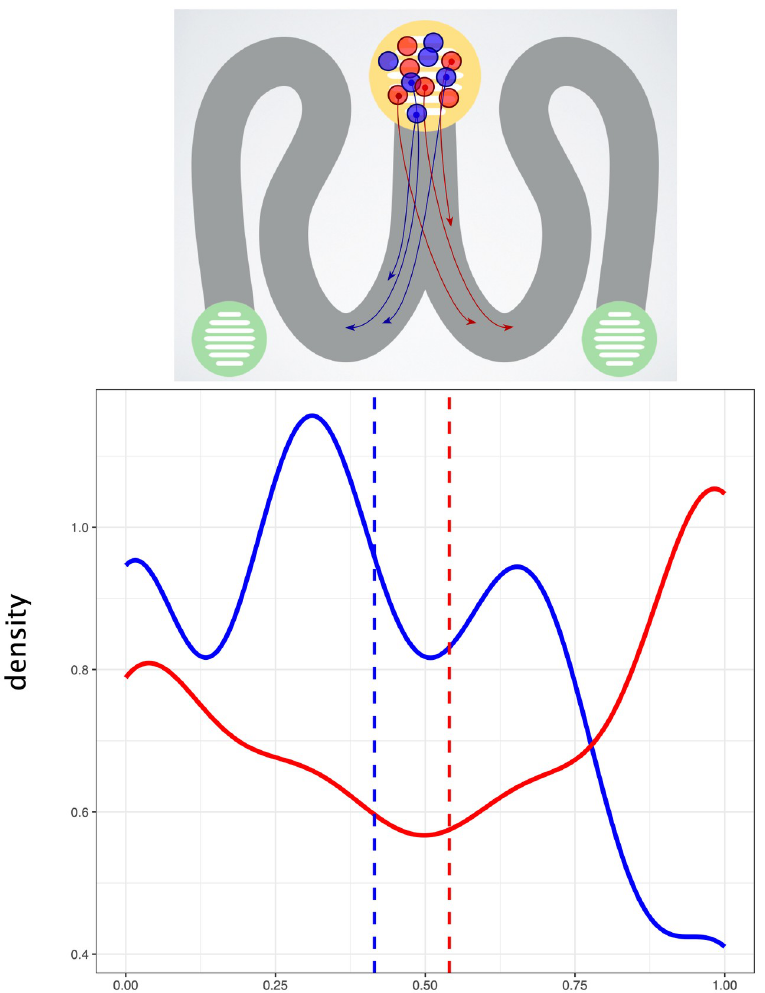
Fig 2. Distribution of participants’ maze choices, split by dot colour. Inset of example trial with confederate dots identified by arrows showing pre-determined movements.